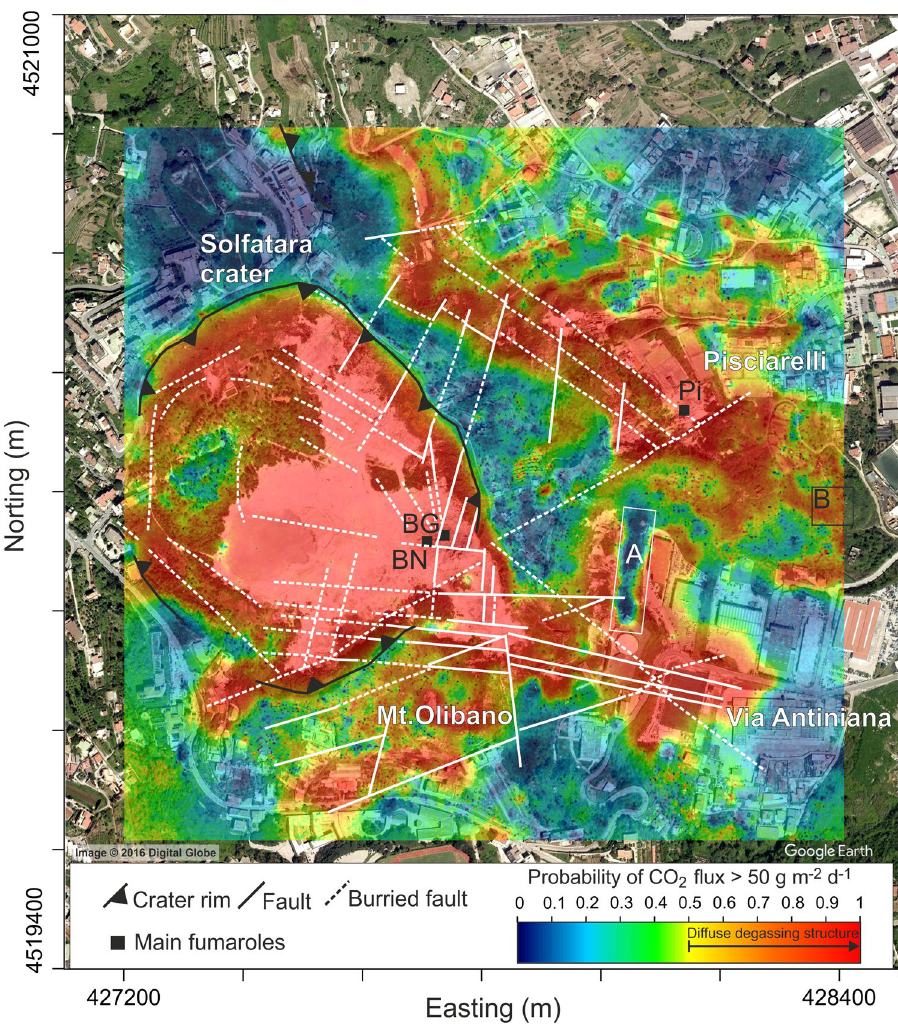
Figure 4. Map of Solfatara diffuse degassing structure (DDS) based on the entire dataset of CO 2 fluxes from 1998 to 2016. The map was produced by sGs method considering a cell size of 2 × 2 m. The map reports the probability that the simulated CO 2 flux is greater than 50 g m − 2 d − 1 , selected as the threshold for a pure biogenic CO 2 flux, processing the results of 100 simulations (see Methods). Yellow to red colours i.e., probability of CO 2 flux > 50 g m − 2 d − 1 higher than 50%, define the Solfatara DDS where degassing of deeply derived CO 2 occurs. Tectonic structures are from ref. 60. Coordinates are reported as meters projection UTM European Datum 50. The map was created with the software Surfer, Version 11.0.642,